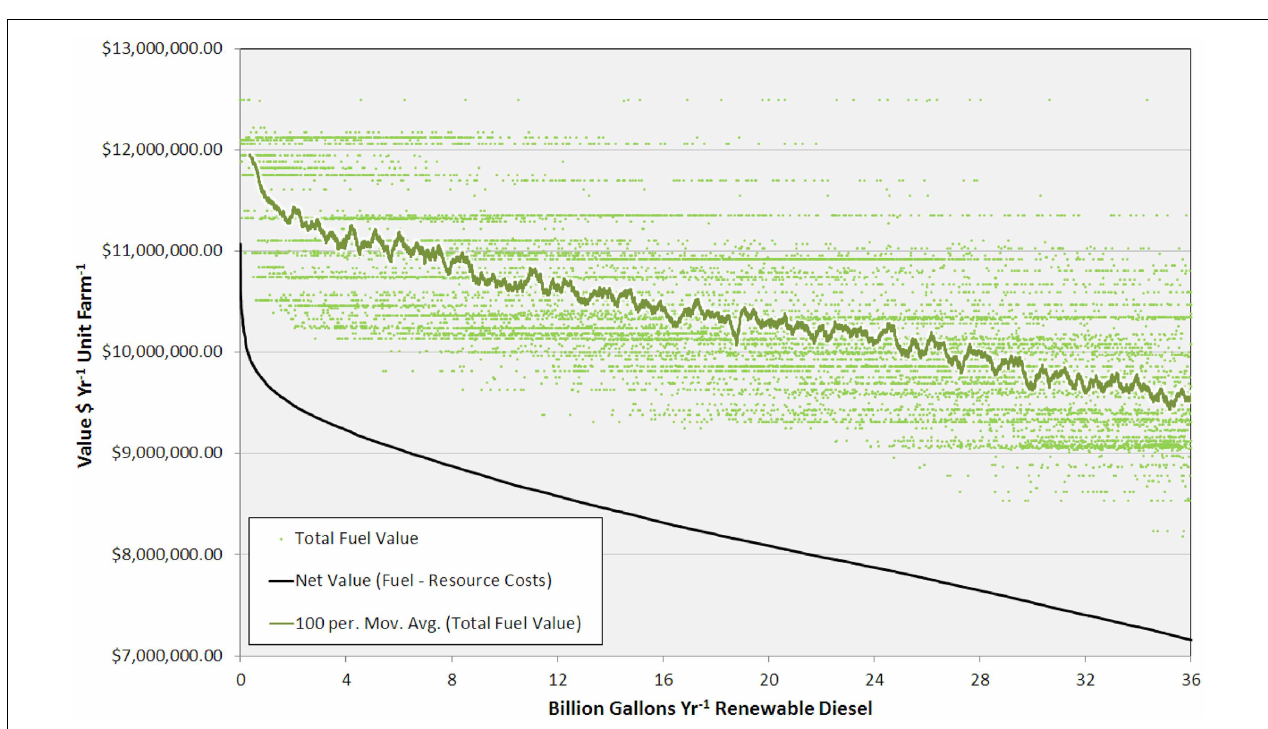
FIGURE 5 | Graph showing total fuel value (for each unit farm and as a 100 site running average) and net value versus RD production from 0 to 36 BGY